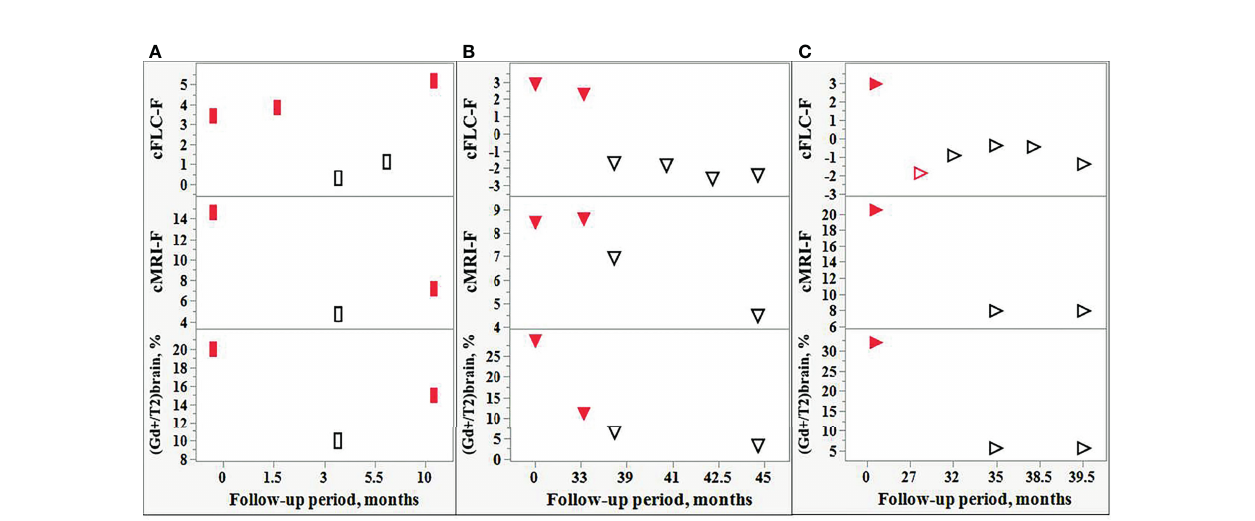
FIGURE 7 | Comparison of the changes in the FLC levels and MRI data during the follow-up of individual POMS patients. Changes in the cFLC-F values are in concordance with those of cMRI-F and also with the relative amount active lesions in the brain, i.e., [(Gd+)/T2] brain ,%. Red fi lled rectangles [ (A) : POMS patient #5] and red fi lled triangles [ (B, C) : POMS patients #1 and #46] indicate relapse. Red empty triangle [ (C) : patient #46] - post-relapse. Black empty rectangles (A) and triangles (B, C) -